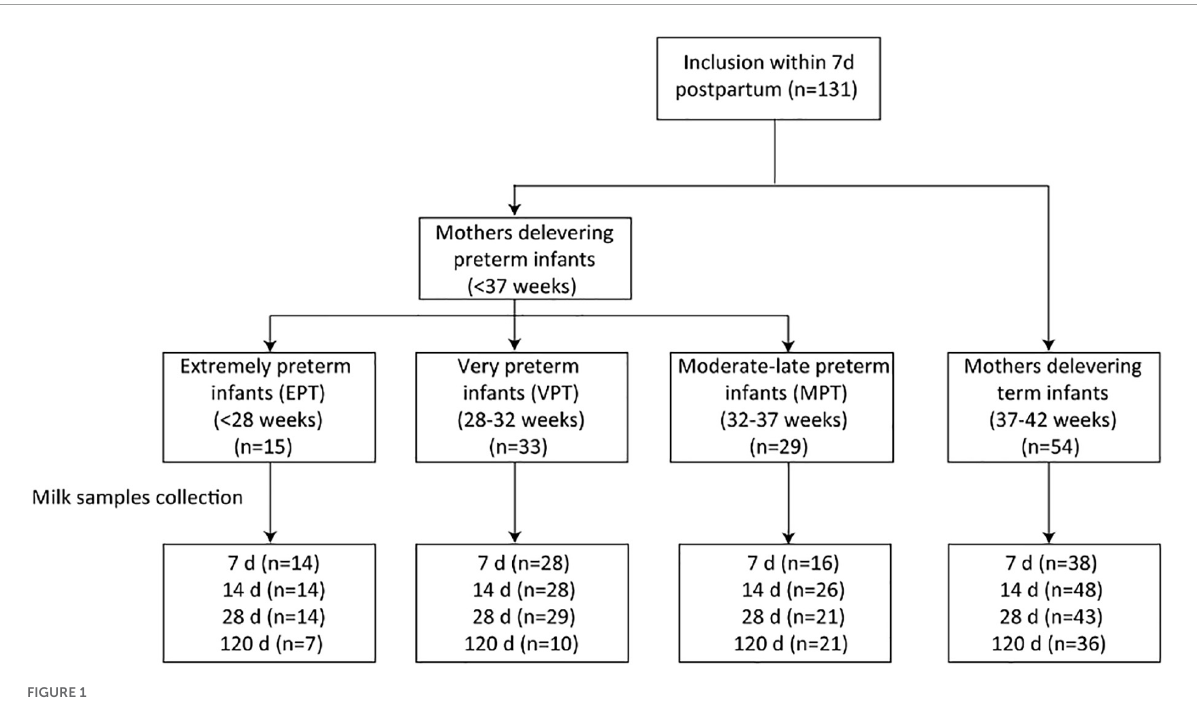
FIGURE1 Flow chart of the study